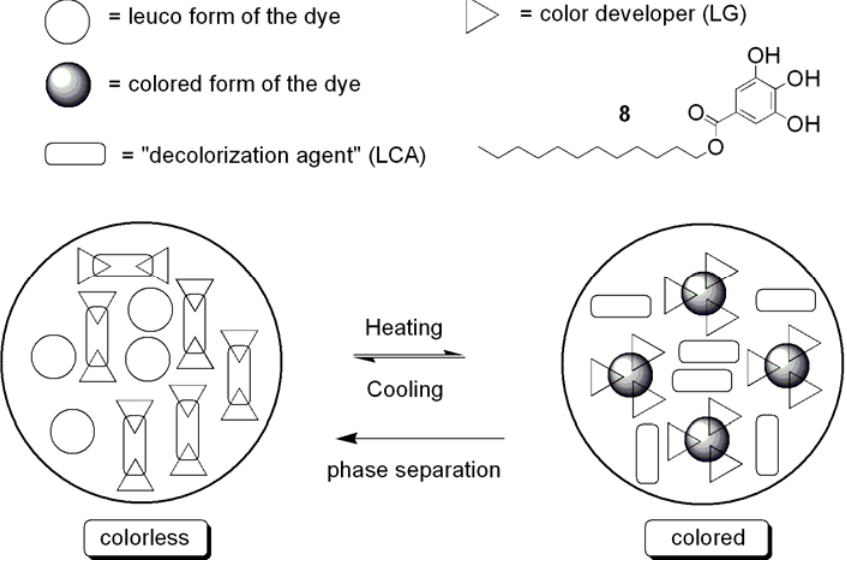
Figure 8. Thermochromic behavior of dye/developer/“decolorizing agent”